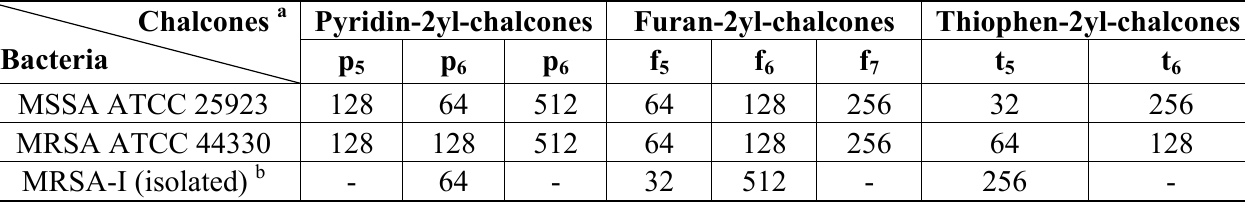
Table 2. Anti- Staphylococcus aureus activity of the synthetic compounds (minimum inhibitory concentration in